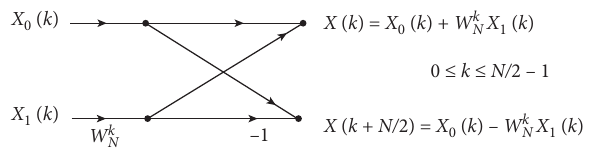
Figure 1: Flow diagram of butterfly operational